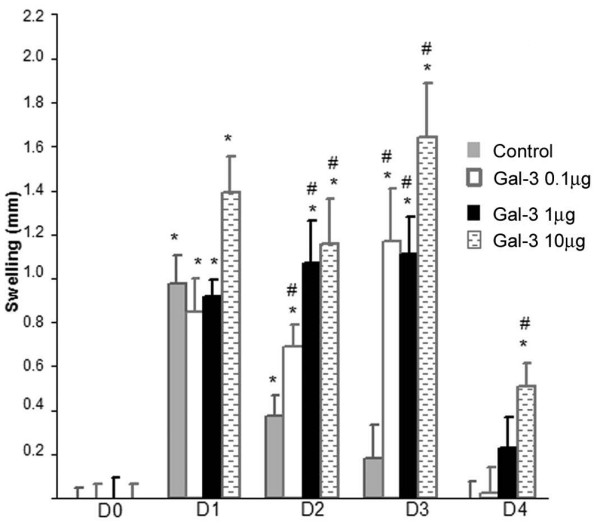
Mouse knee swelling measurement. Galectin-3 (gal-3) was injected in both knees. Animals were examined daily and knee diameter measured using a digital calliper as described in Materials and methods. The swelling corresponded to the difference between joint diameter measured every day and joint diameter prior to the injection (D0). D0 was given the value of 0. Control (Ctl): injection of PBS. Each group contained four animals. *p versus same conditions as D0; #p versus control of the corresponding day.